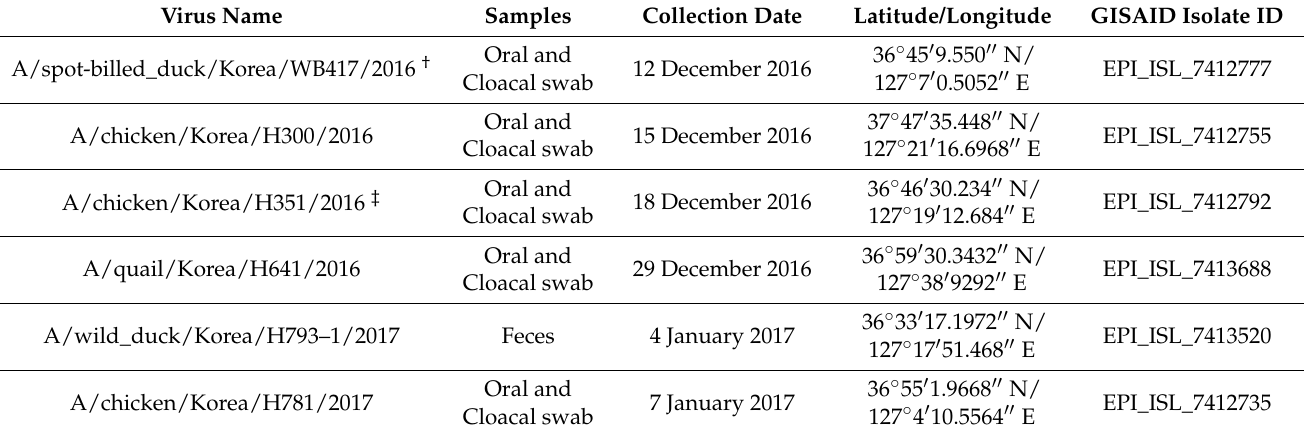
Table 1. Highly pathogenic avian influenza H5N6 isolates used in the phylogenetic study ( n = 6).